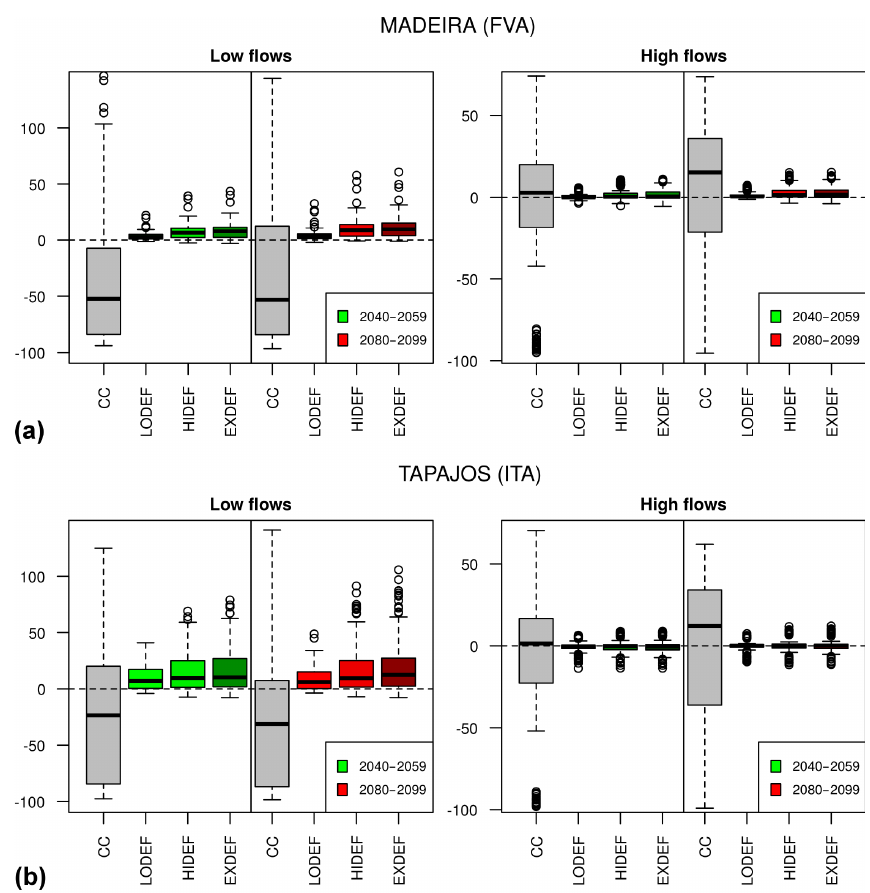
Figure 13. Relative change (%) of the first deciles (i.e. low flow, left panels) and the last deciles (i.e. high flow, right panels) of river discharge due to climate change (grey) and deforestation combined to climate change (three LCC scenarios) of (a) the Madeira (at Fazenda Vista Alegre – FVA) and (b) the Tapajós (at Itaituba – ITA) for the middle (green) and the end (red) of the century. The changes are simulated by the ensemble of six simulations (two LSMs × three GCM forcings). The change of low flows and high flows cannot be represented with INLAND-DGVM because it does not include a routing scheme. The boxes correspond to the interquartile range (IQR, the distance between the 25th and the 75th percentiles), the bold horizontal line in each box is the median and the whiskers extend from the minimum value to the maximum value unless the distance from the minimum (maximum) value to the first (third) quartile is more than 1.5 times the IQR. Circles indicate the outliers that are 1.5 × IQR below (above) the 25th percentile (75th